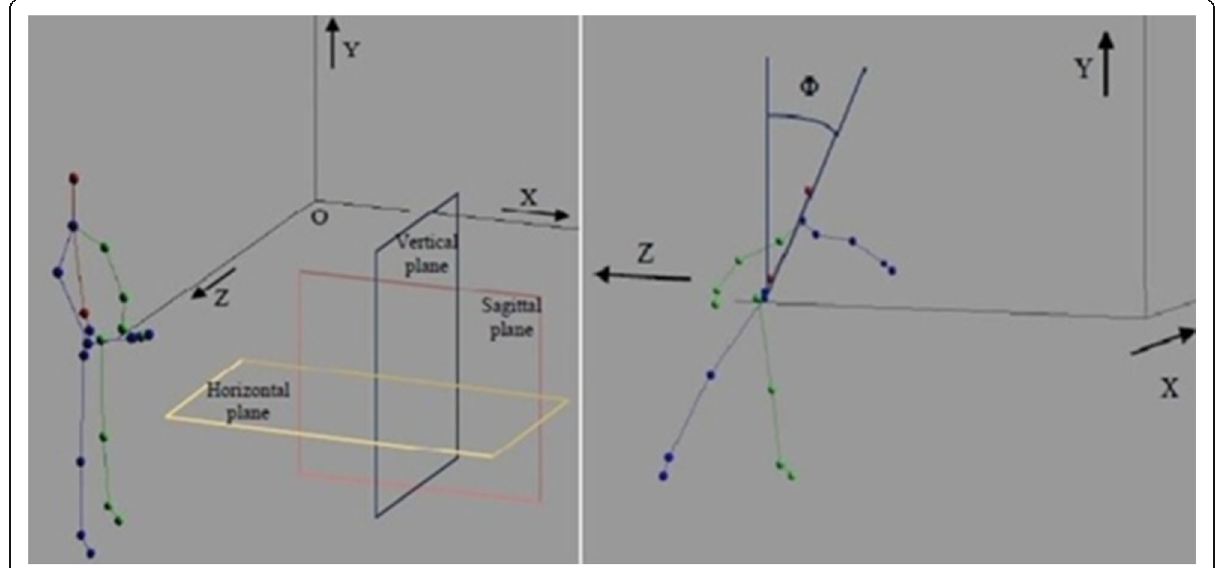
Fig. 1 Body skeleton joints new positions after transforms application and body planes representation ( a ); illustration of forward tilt angle ( b